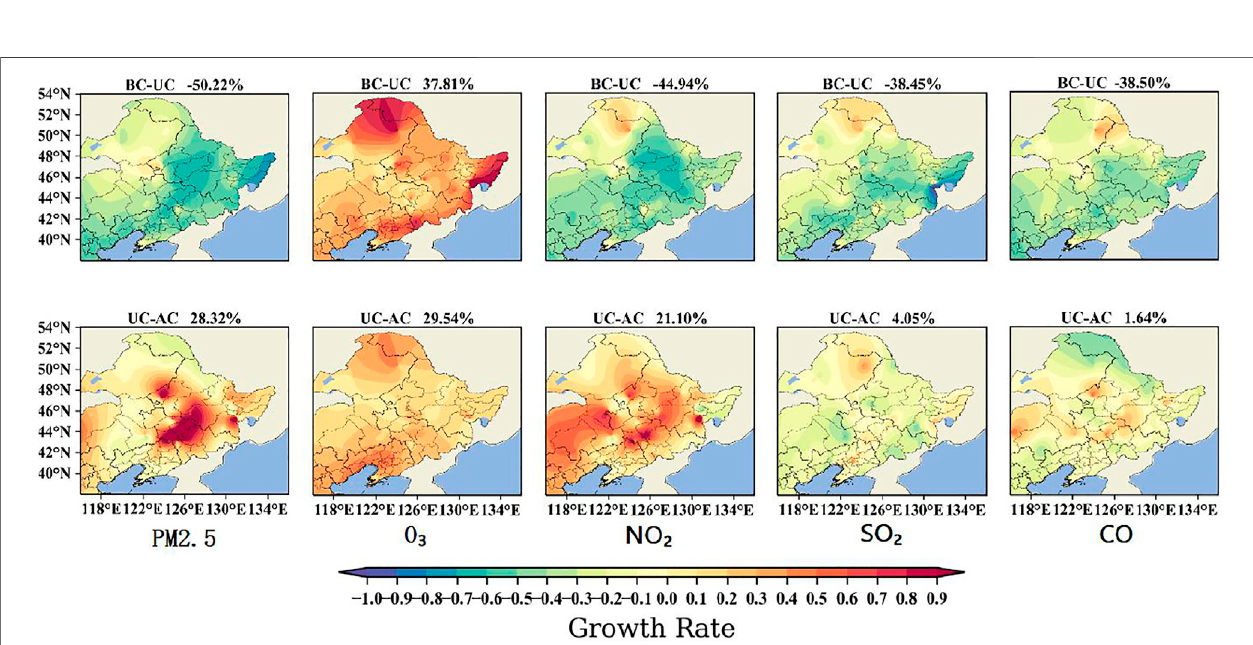
FIGURE9| Spatialdistribution oftheconcentrationchangerates ofthe fi vemainpollutantsin theBC-UCand UC-AC phases during the lockdown period in 2020.